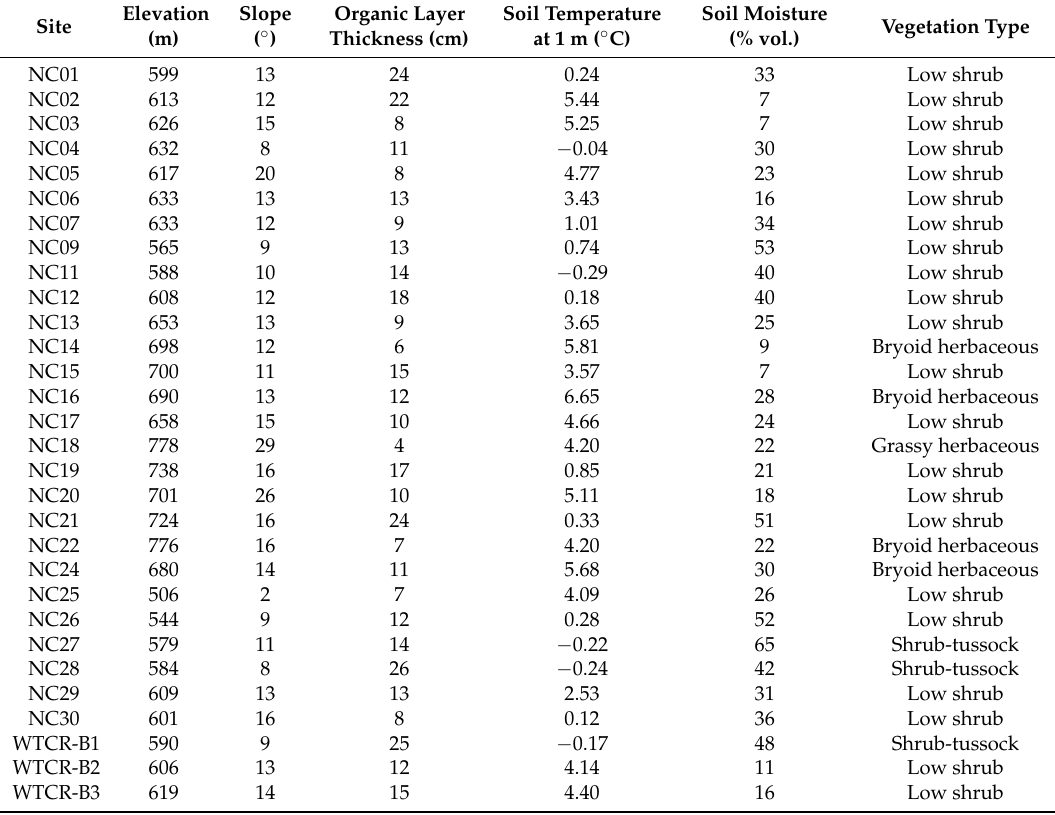
Table 1. Site-level environmental data ( n =